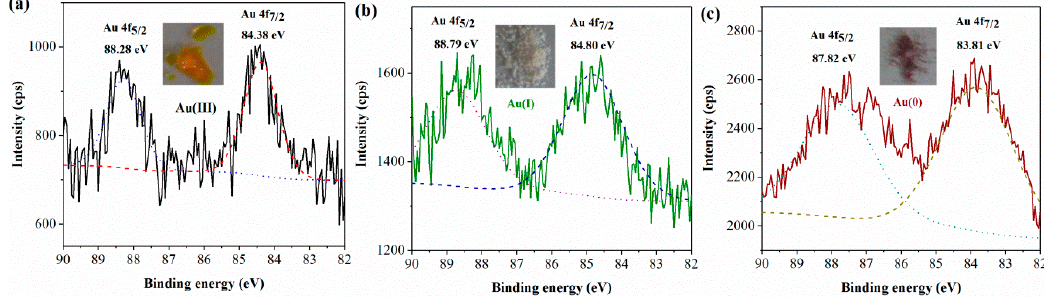
Figure 3. XPS spectra of the Au(4f) region of interaction with bacteria for ( a ) 0 h; ( b ) 1 h; and ( c ) 48 h.